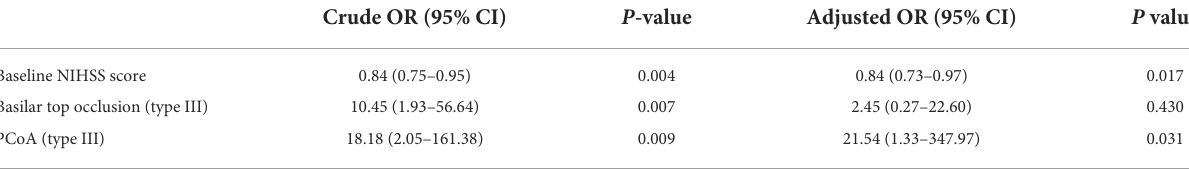
TABLE 3 Factors associated with good functional outcome (mRS 0–2 at 3 months).